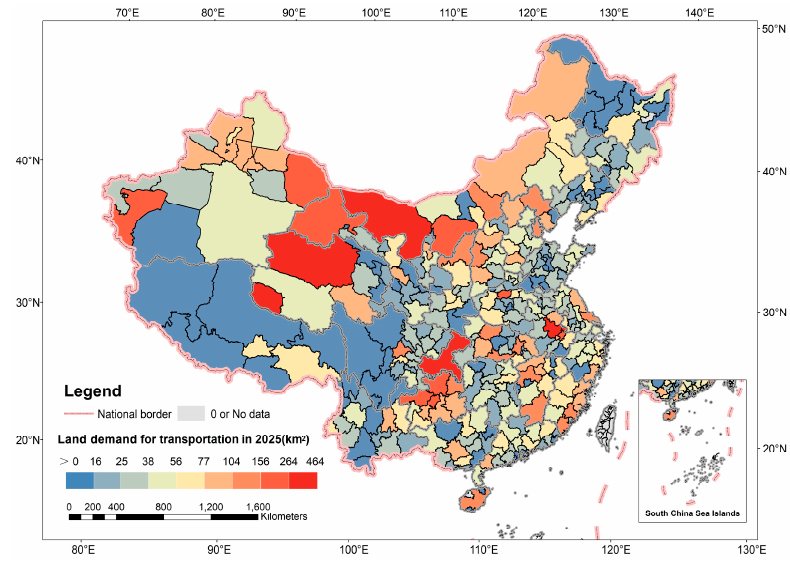
Figure 7. Land demand forecast for transportation in Chinese cities.